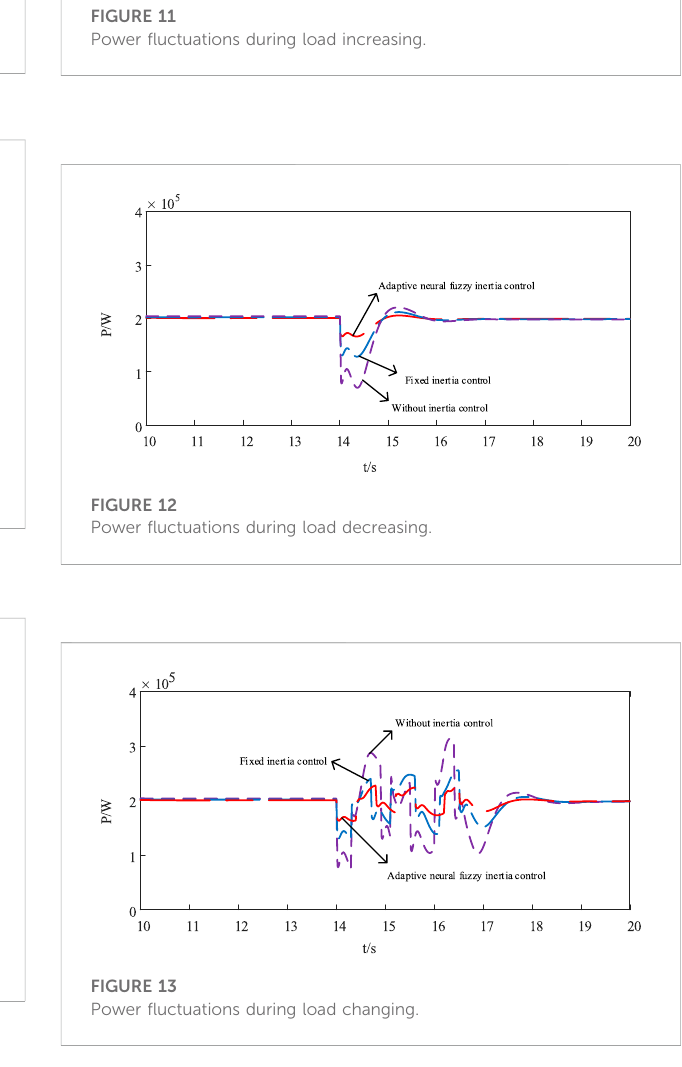
FIGURE 8 Frequency fl uctuations during load increasing.